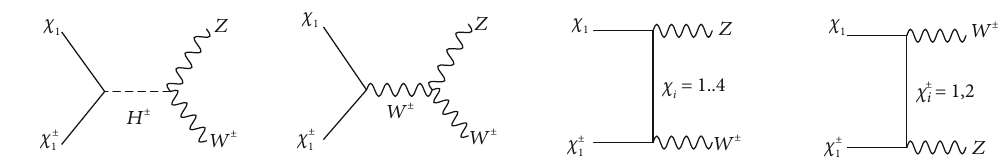
(DM) with the charginos χ ± 1